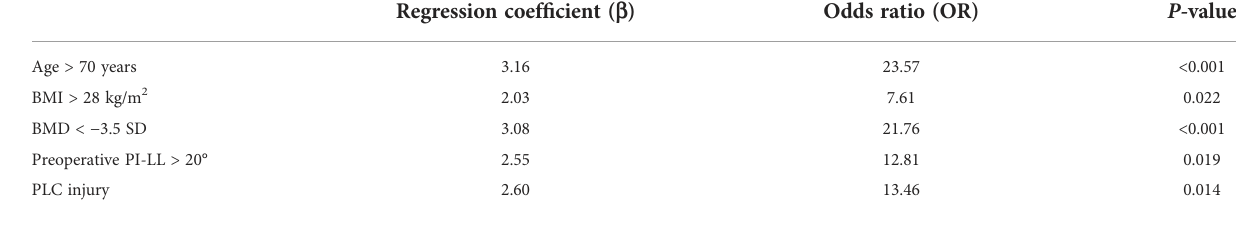
TABLE 2 Multivariate analysis of related variables of predicting postoperative